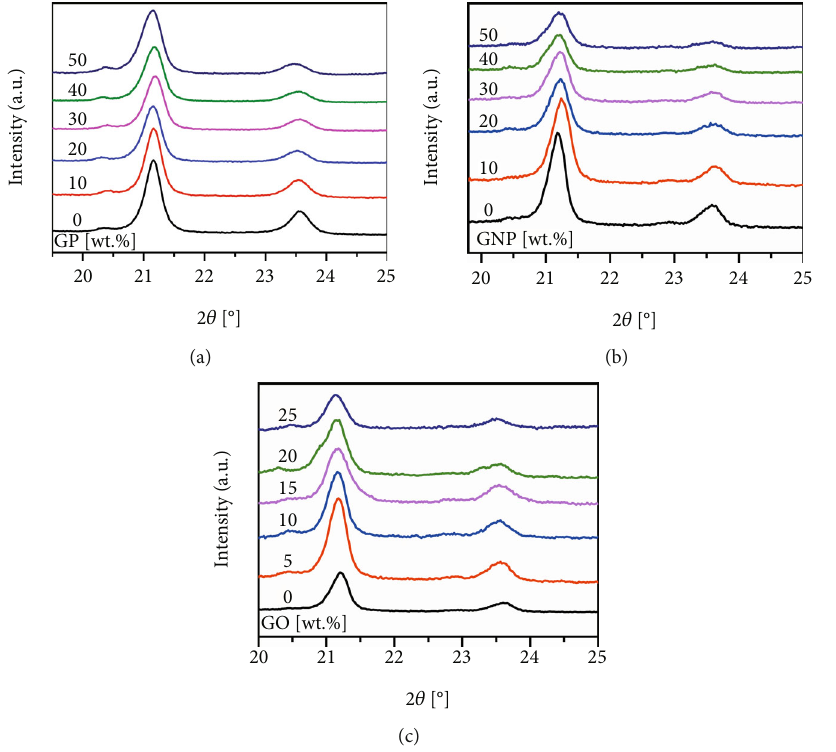
Figure 6: The XRD curves of (a) GP/UHMWPE, (b) GNP/UHMWPE, and (c) GO/UHMWPE